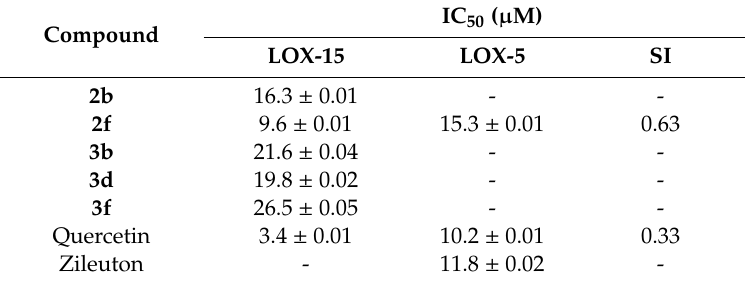
Table 5. Evaluation of 2b , 2f , 3b , 3d , 3f and 3h against lipoxygenases (LOX-5 and